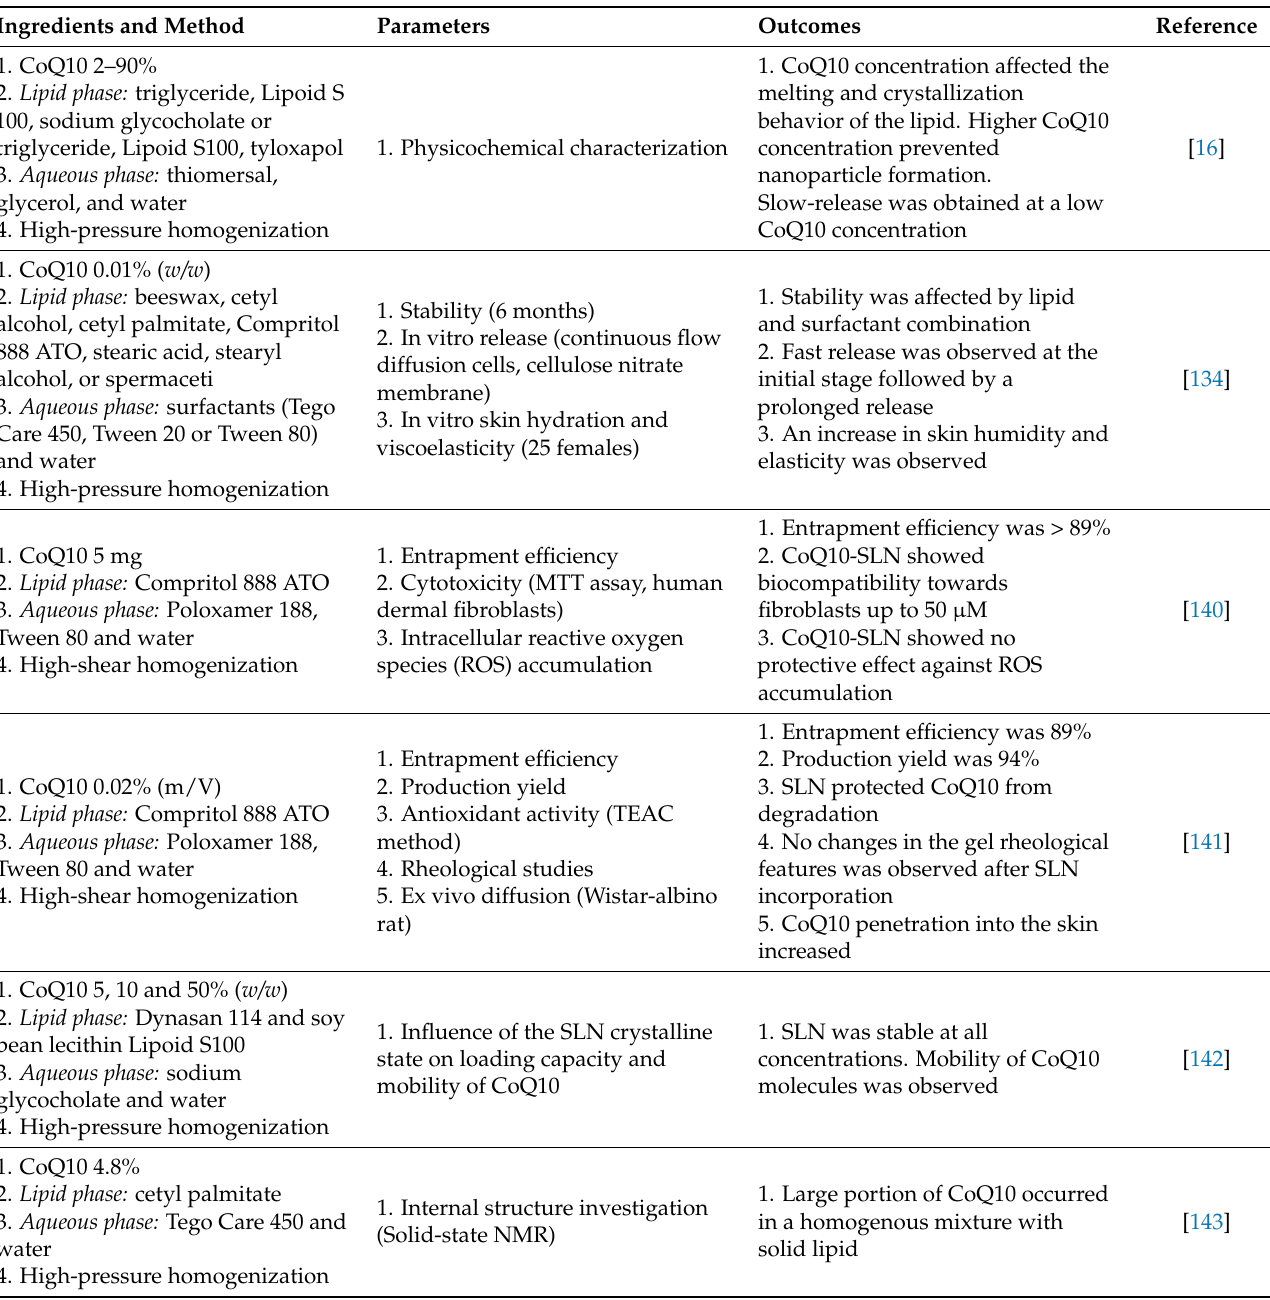
Table 5. An overview of CoQ10 encapsulation in solid lipid nanoparticles (SLN). Ingredients and